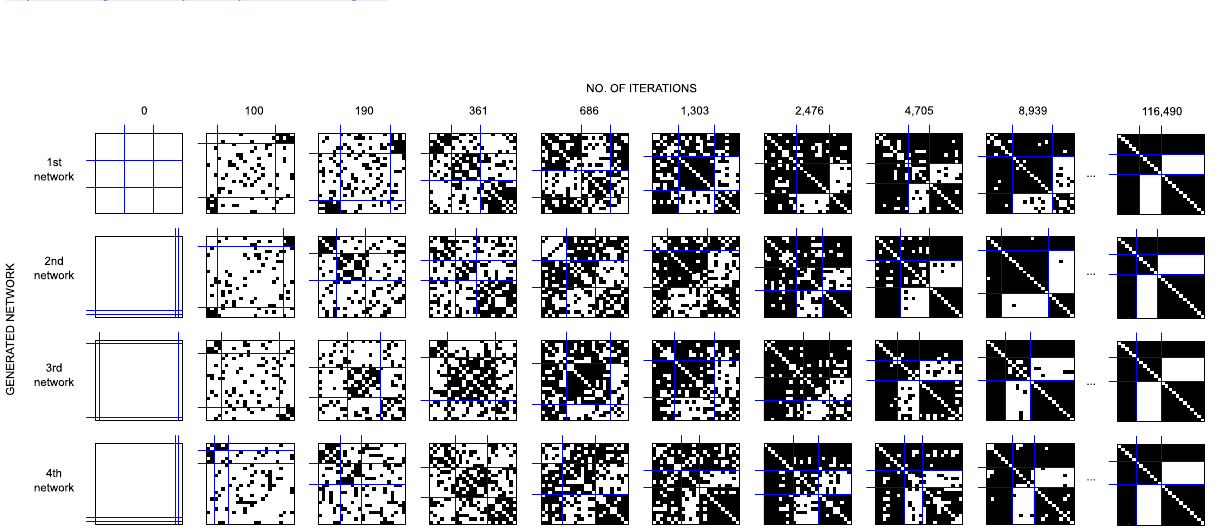
Fig 5. Mean RF for each blockmodel type visualized by lines and the distribution of the density visualized by boxplots. The networks are generated by considering θ = { M = − 0.18, P = 0.74, A = 0.37, T = − 0.35, OSP = 0.42}, q = 5/9, d 0 = 0.